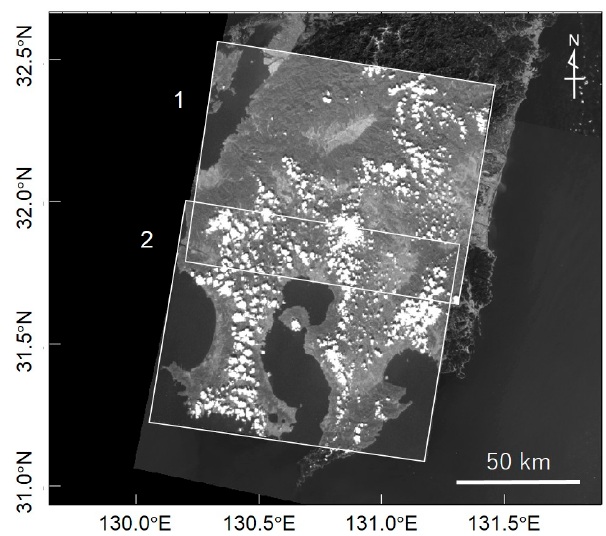
Figure 8. Sequential observations of UNIFORM-1 on 26 September 2015. The numbers represent the order of the two observations, which are temporally separated by 8 s. Base-map images are taken from OLI band 4. Contrasts in the VIS images are enhanced. Table 6. Rotation matrices and rotation angle between the two observations shown in Figure 8.